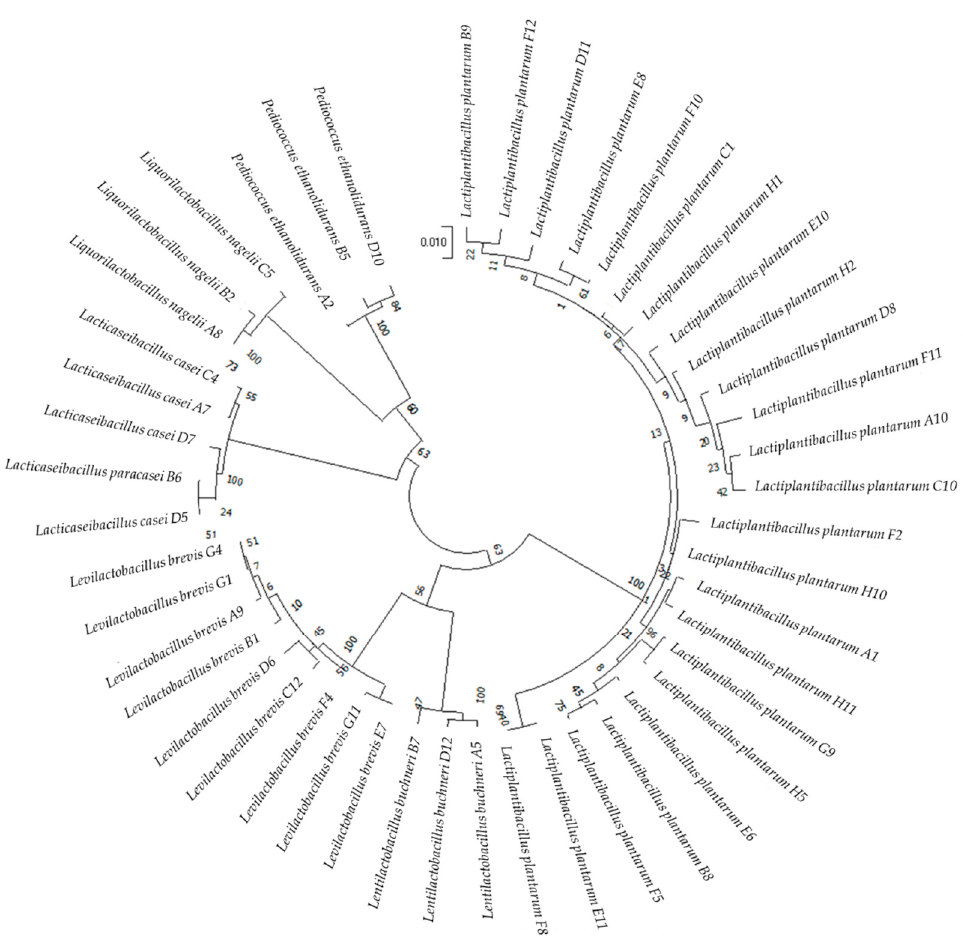
Figure 1. Circular phylogenetic tree showing the relative positions of the 47 LAB strains based on the neighbor-joining method of 16S rRNA genes with 1000 bootstrap replications.